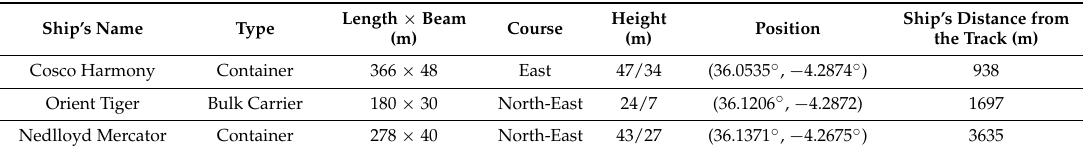
Table 1. Basic information on the three ships sailing in the proximity of the CryoSat-2 track analyzed. Date: 8 August 2012. Satellite’s time (UTC): 11:55